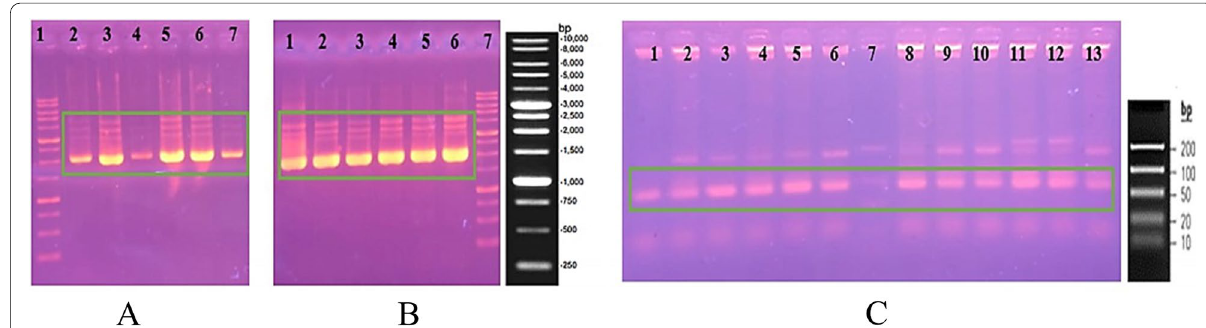
Fig. 3 Electrophoretic of isolation plasmid and amplification PCR. A Electrophoretic of isolation plasmid. 1 Marker 1 kb, 2 S15K1, 3 S15K3, 4 S15K5, 5 S15K13, 6 S15K15, 7 S15K17. B Electrophoretic of isolation plasmid. 1 S15K2, 2 S15K4, 3 S15K6, 4 S15K12, 5 S15K16, 6 S15K20, 7 marker 1 kb. C